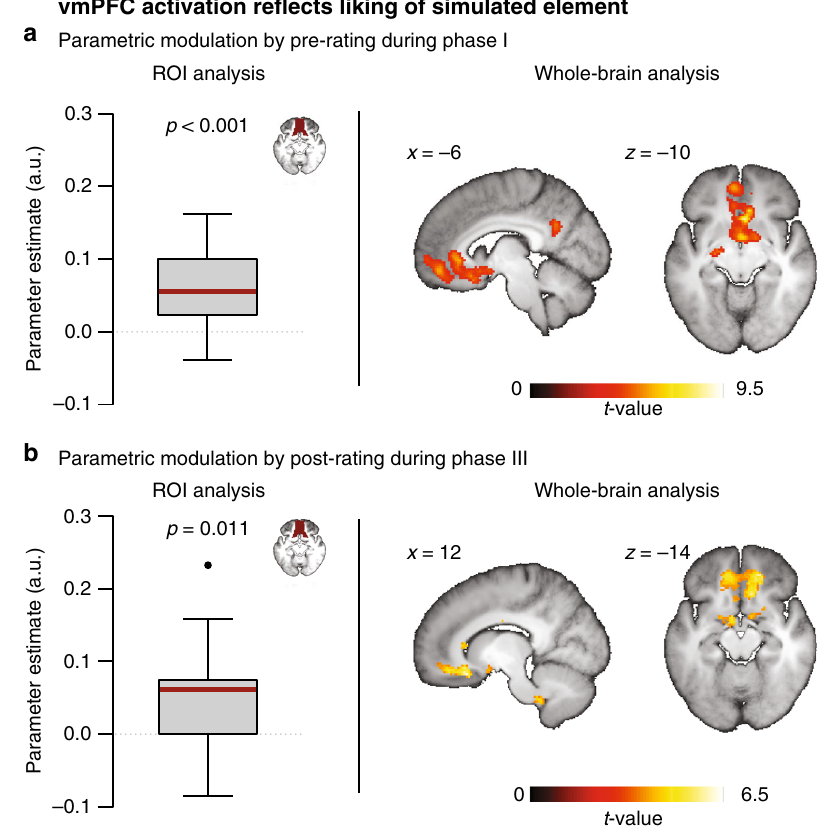
Fig. 3 vmPFC activity re fl ects the value of the imagined element. Consistent across ( a ) phase I and ( b ) phase III, BOLD signal in the vmPFC was modulated by liking (as an index of value) of the people and places. Representations encoded in this region thus seem to carry information about the elements ’ affective value. Note that the greatest source of variance in value stems from the inclusion of liked and disliked people, though the model also predicts that BOLD signal for the neutral places falls in between those extremes. Boxplots indicate the median, central quartiles, and + / − 2.7 SD. The dot indicates an outlier beyond that range. For display purposes, exploratory whole-brain maps are thresholded at p < 0.001, uncorrected, with a cluster extend of at least 15 voxels. a.u., arbitrary